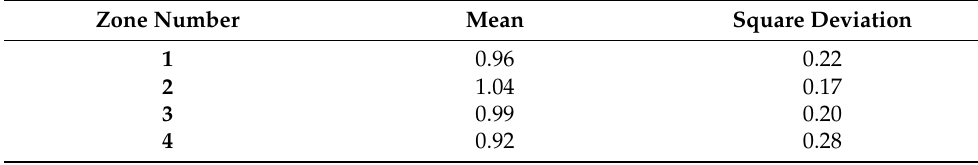
Table 4. Mean and square deviation of A / A ref of different zones of model with θ a = − 4 ◦ . Zone Number